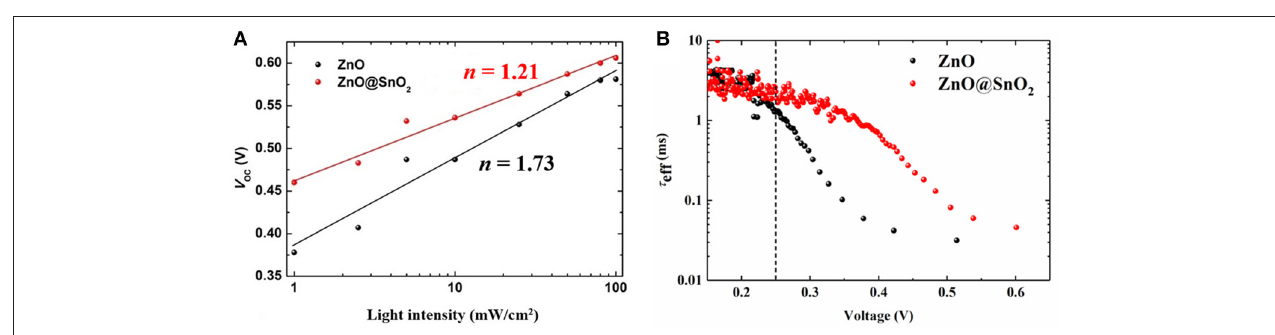
FIGURE 6 | (A) Light-intensity dependence of V oc for CQDSCs with and without SnO 2 passivation. The solid black and red lines are the fitting curves. (B) τ eff of CQDSCs with or without SnO 2 passivation that was calculated from the TPV decay curves of the devices which were shown in Figure S6 .